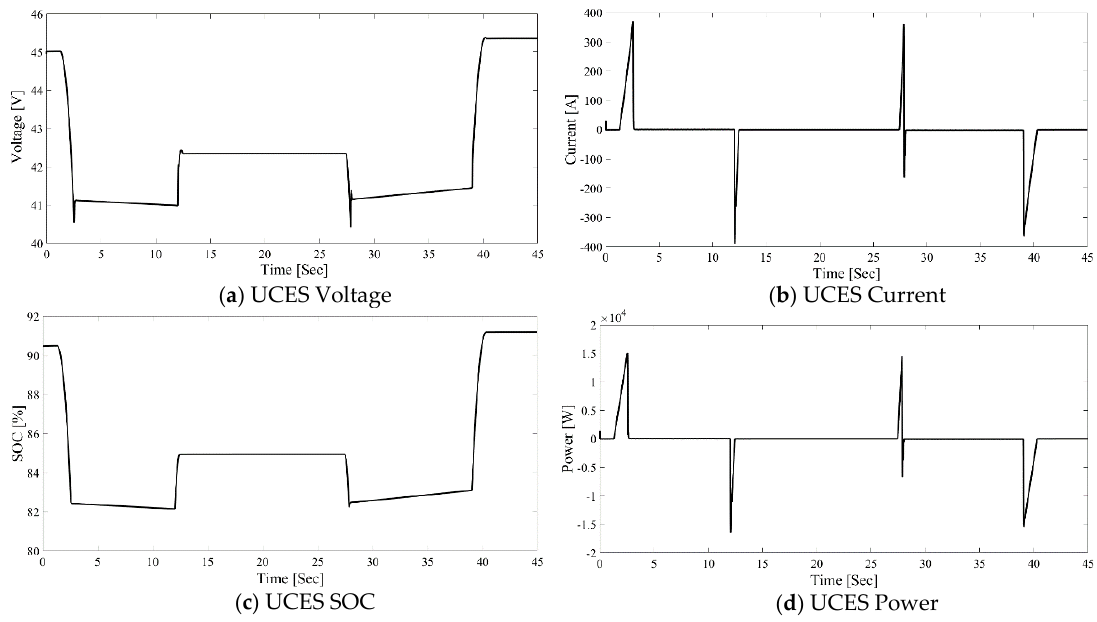
Figure 12. UCES parameters in a complete 45-s elevator working cycle.